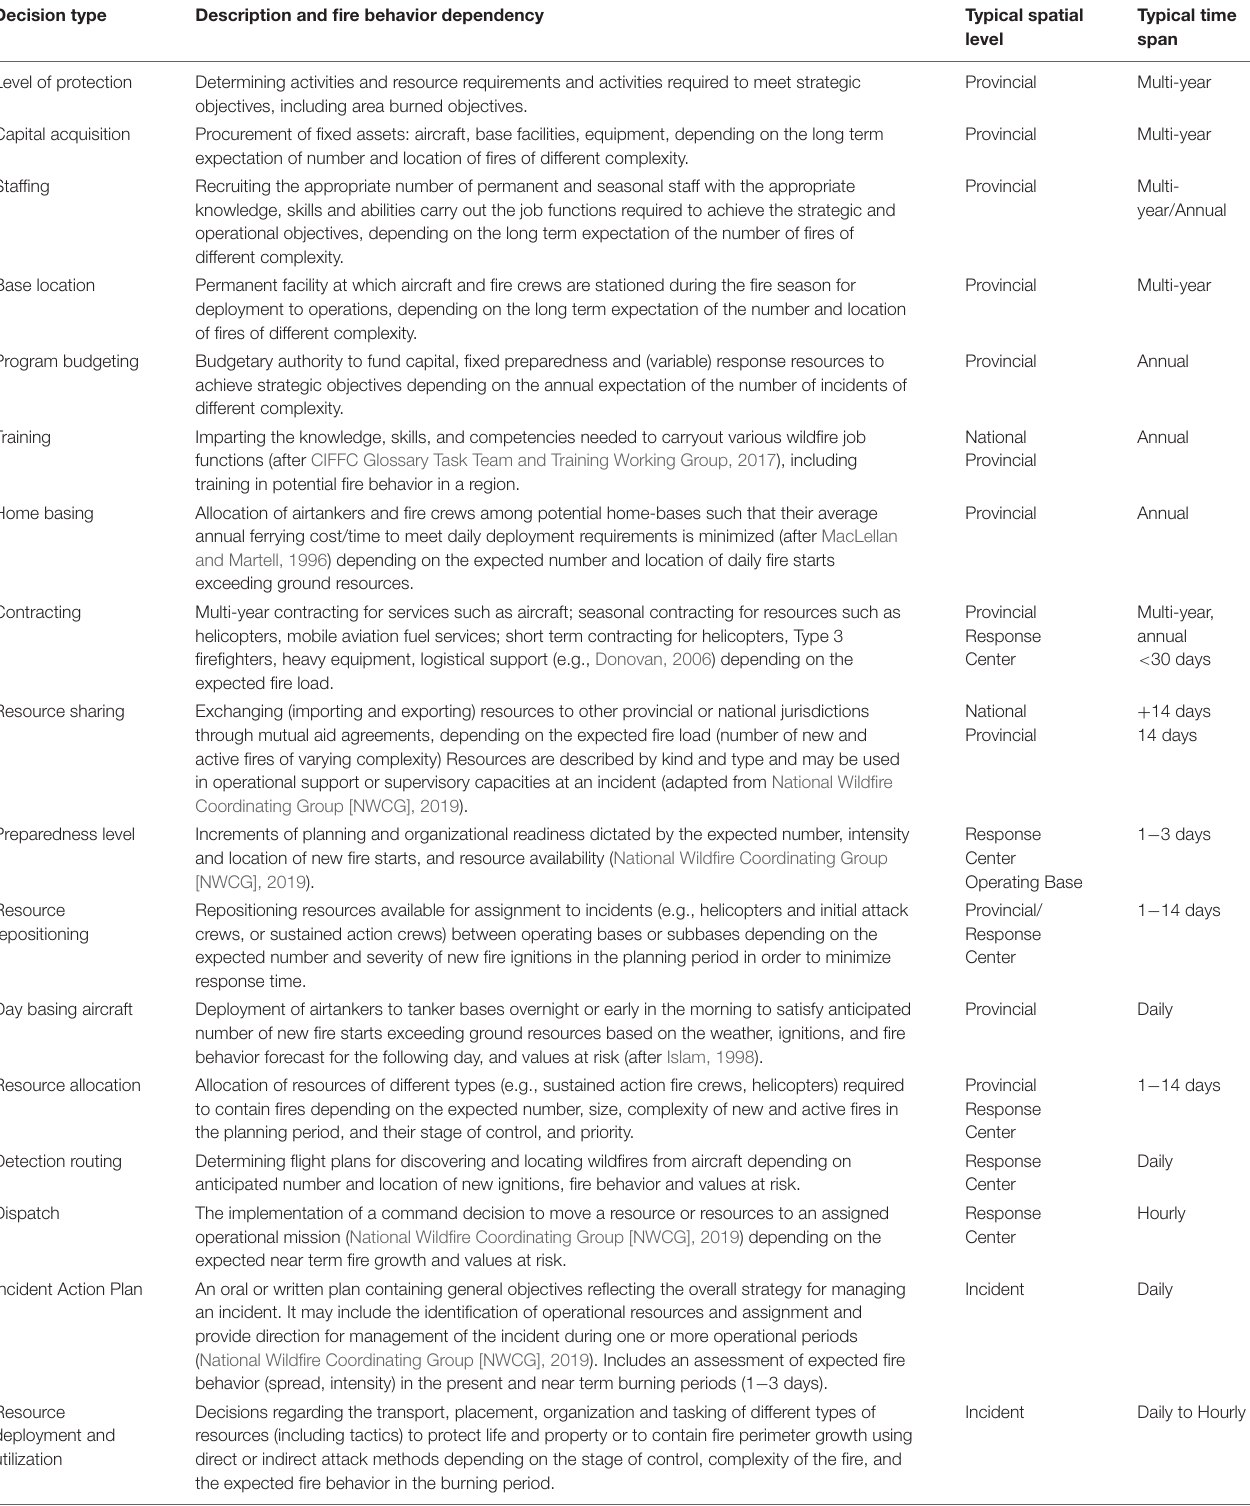
TABLE A1 | Examples of some types of fire management decisions in Canada and links to fire